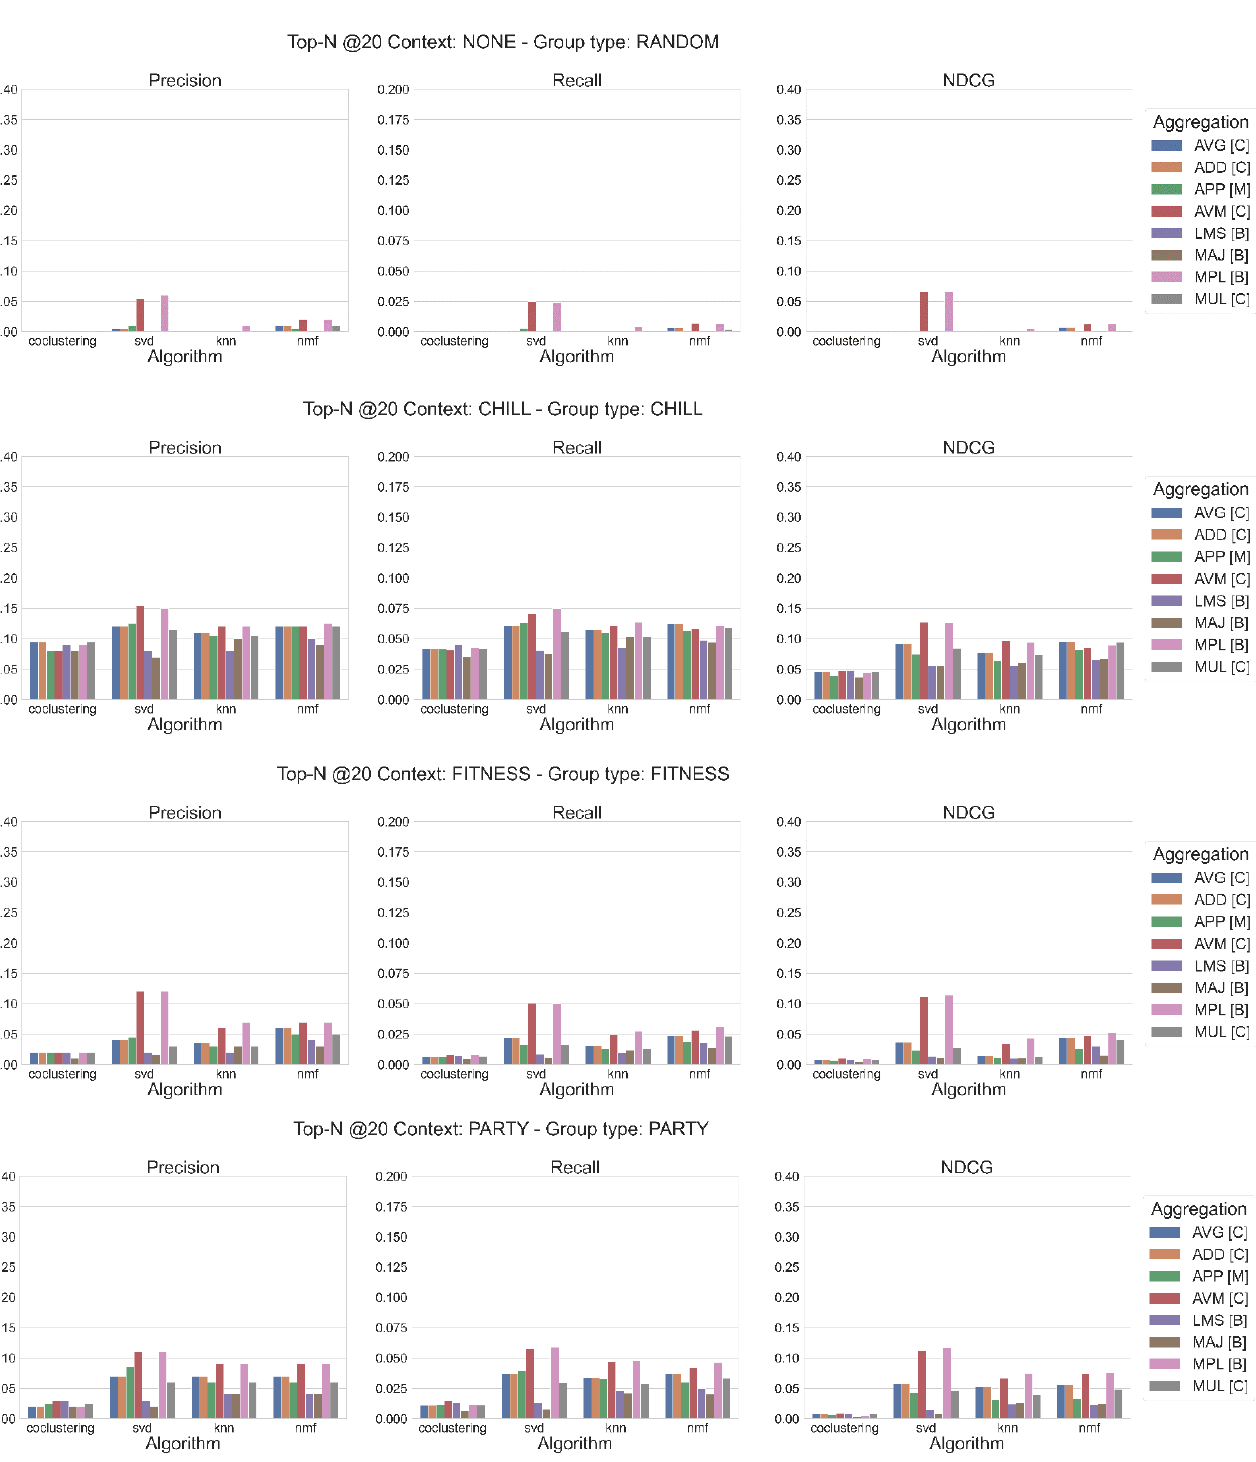
Figure 6. Comparison of metrics, based on aggregation methods and algorithms, for a fixed context in top-n@20 recommendations for LFM-lb-small-spotify.